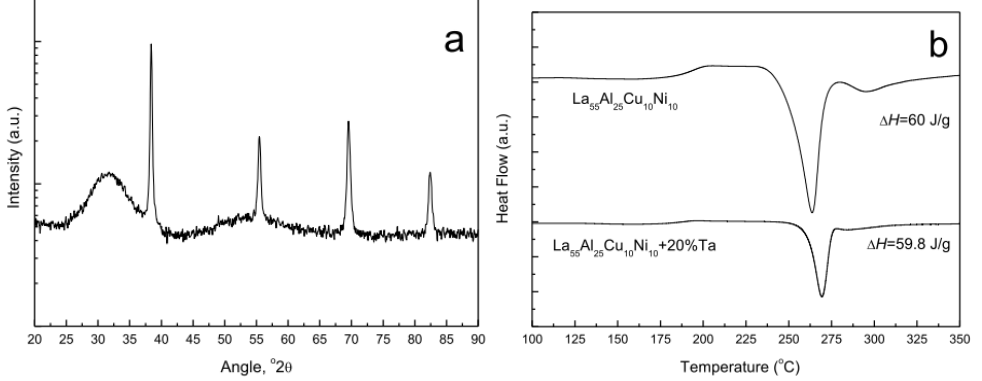
Al Cu Ni and its 55 25 10 10